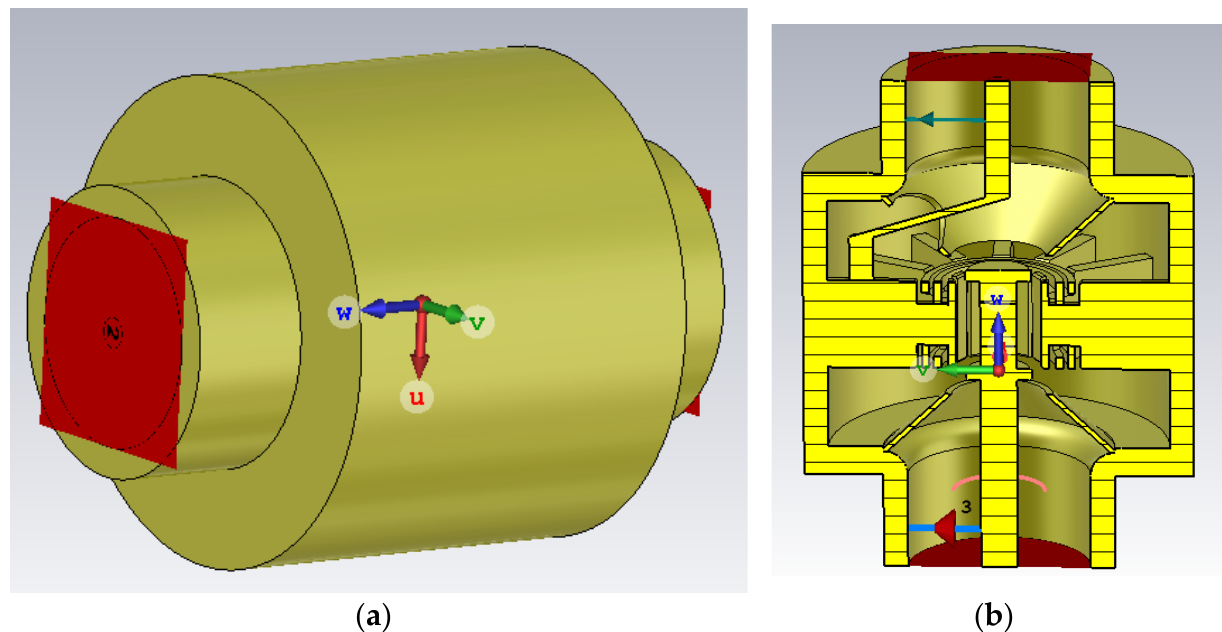
Figure 1. CST Particle Studio simulation model of the 12-vanes and 2.45 GHz CW magnetron. ( a ) Appearance and structure diagram of the magnetron. ( b ) Internal structure diagram of the magnetron. Table 1. Dimensions of the device.